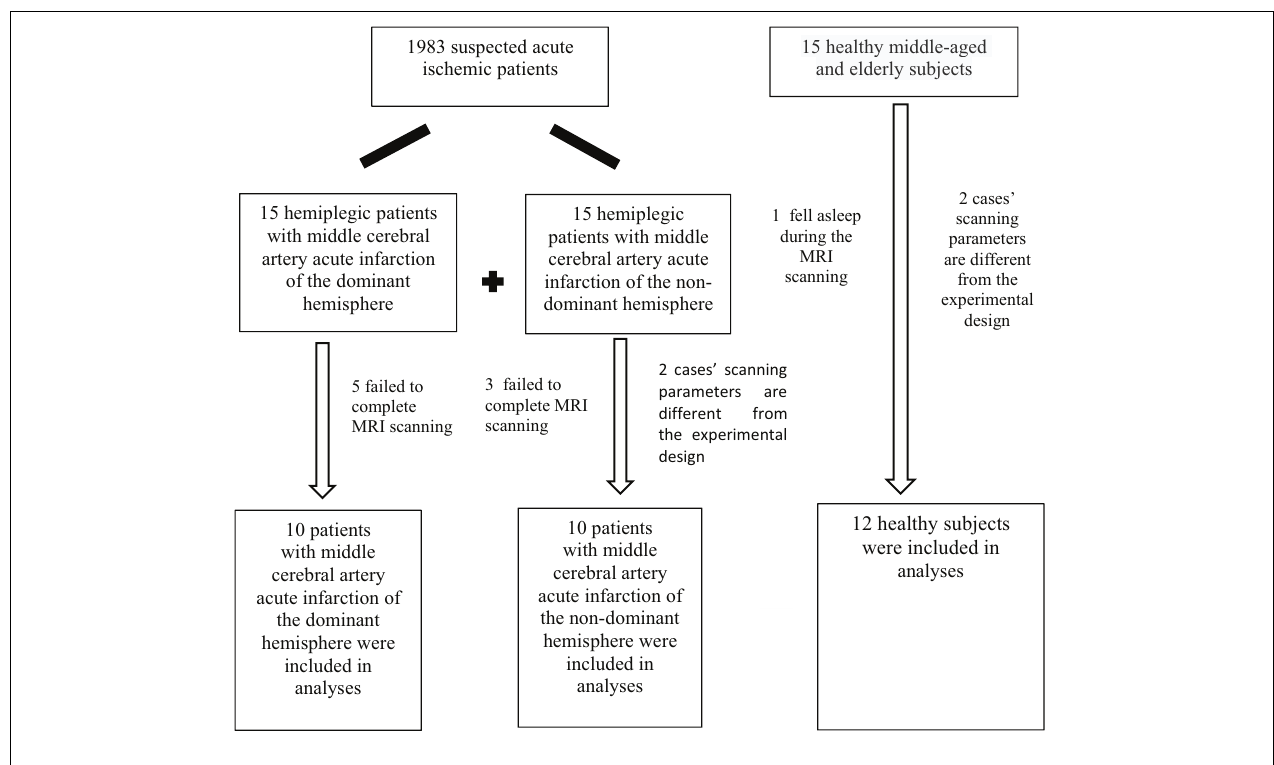
FIGURE 1 | Integration of stroke patients and healthy subjects.